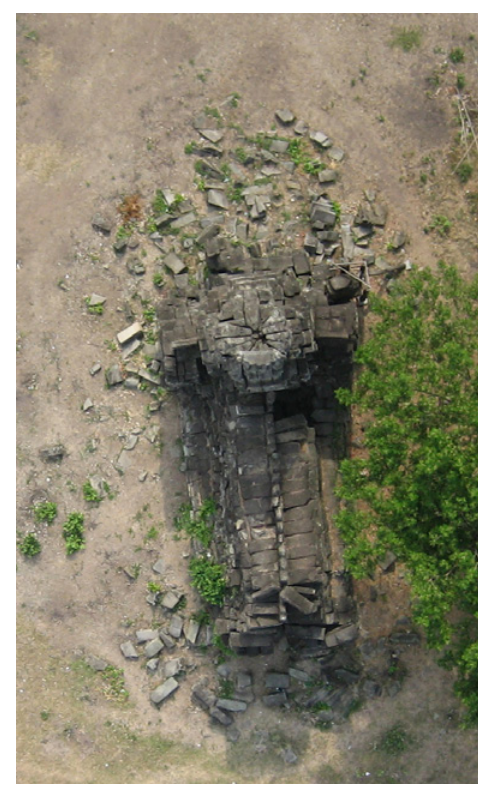
Figure 6: The Daramsala in Banteay Chhmar,